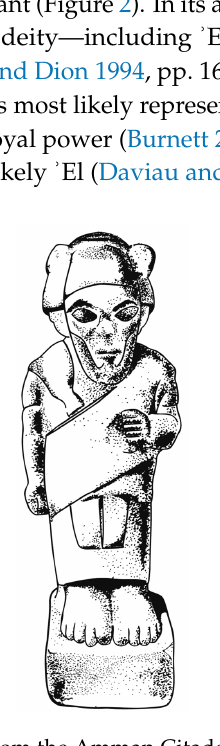
Figure 2. Atef crowned statuette from the Amman Citadel. Drawing by Thomas Norman.